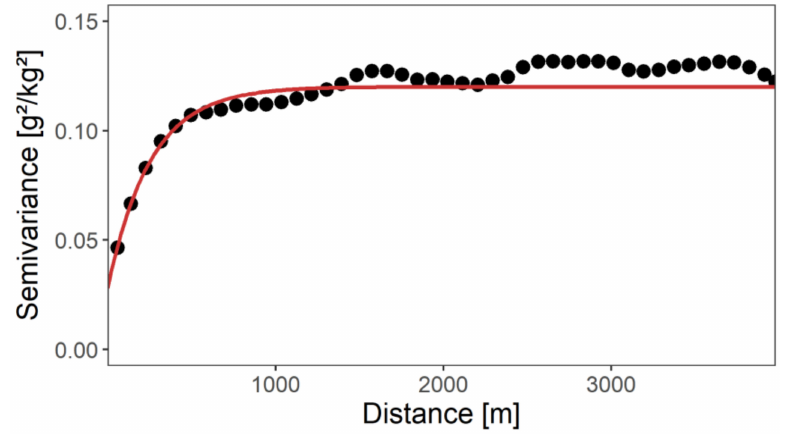
Figure 11. Variogram of the predicted SOC data for 8000 random locations. The points are the experimental semivariance (expressed in g 2 / kg 2 ) values whereas the red line is the model of